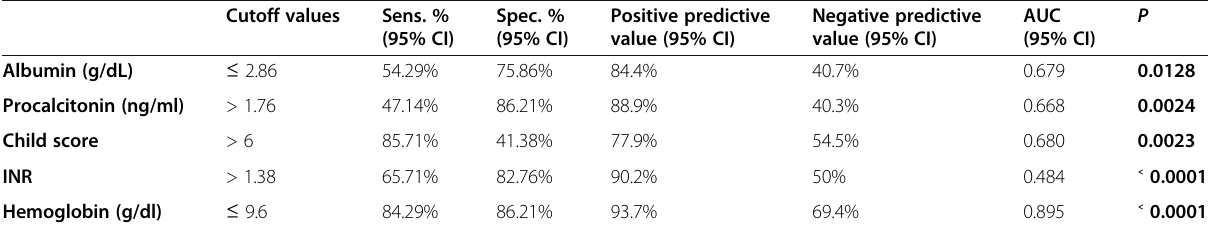
Table 6 Specificity and sensitivity of different parameters in predicting esophageal bleeding (EVs) in our study ( n = 99) Cutoff